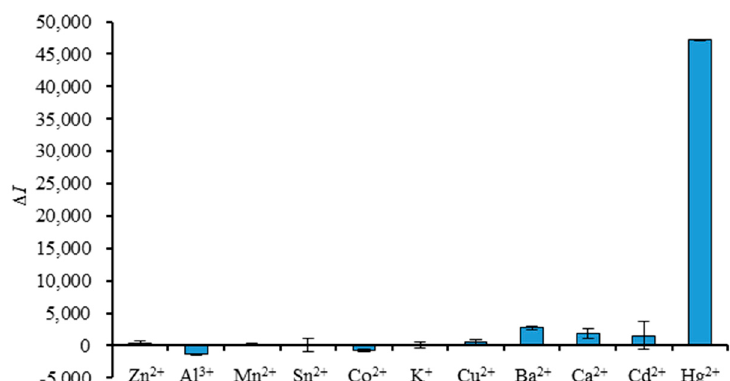
Figure 6. The fluorescence intensity changes in MB3 interacting with different metal ions.